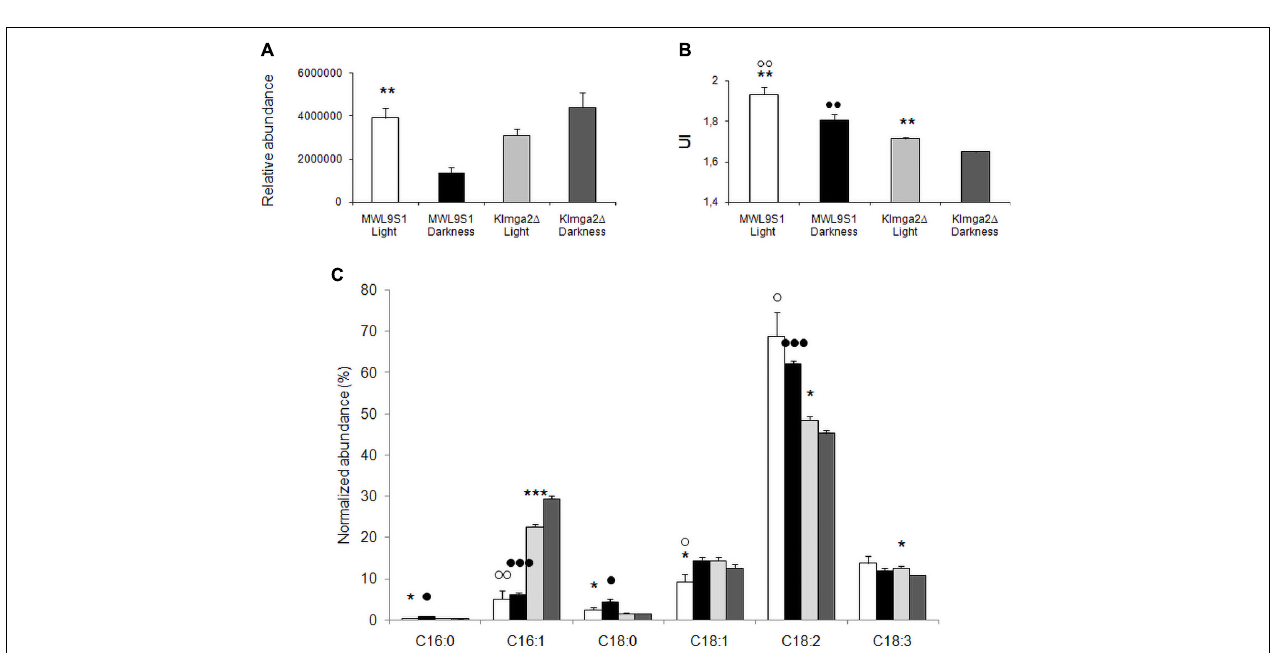
FIGURE 9 | Fatty acid composition of the wild type MWL9S1 and Klmga2 (cid:49) mutant strain. Cells were grown in overnight light or darkness. (A,B) Report total fatty acid (FA) content (relative abundance with respect to 9-hydroxy octadecadienoic d 4 acid, 9-HODE d 4 ) and unsaturation indexes (UI) of the wild type and deleted mutant strain, respectively, with SD reported. (C) Reports amounts of palmitic (C16:0), palmitoleic (C16:1), stearic (C18:0), oleic (C18:1 (cid:49) 9), linoleic (C18:2 (cid:49) 9, (cid:49) 12), and linolenic (C18:3 (cid:49) 9, (cid:49) 12, (cid:49) 15) acids (relative abundance with respect to HODE, normalized to the total amount of FAs). Results with SD are means of three independent determinations. Statistical relevance: stars = light vs dark, white dots = wild type vs mutant (light conditions), black dots = wild type vs mutant (dark conditions); one star or white/black dot = p < 0.05, two stars or white/black dots = p < 0.01 and three stars or white/black dots = p < 0.001.